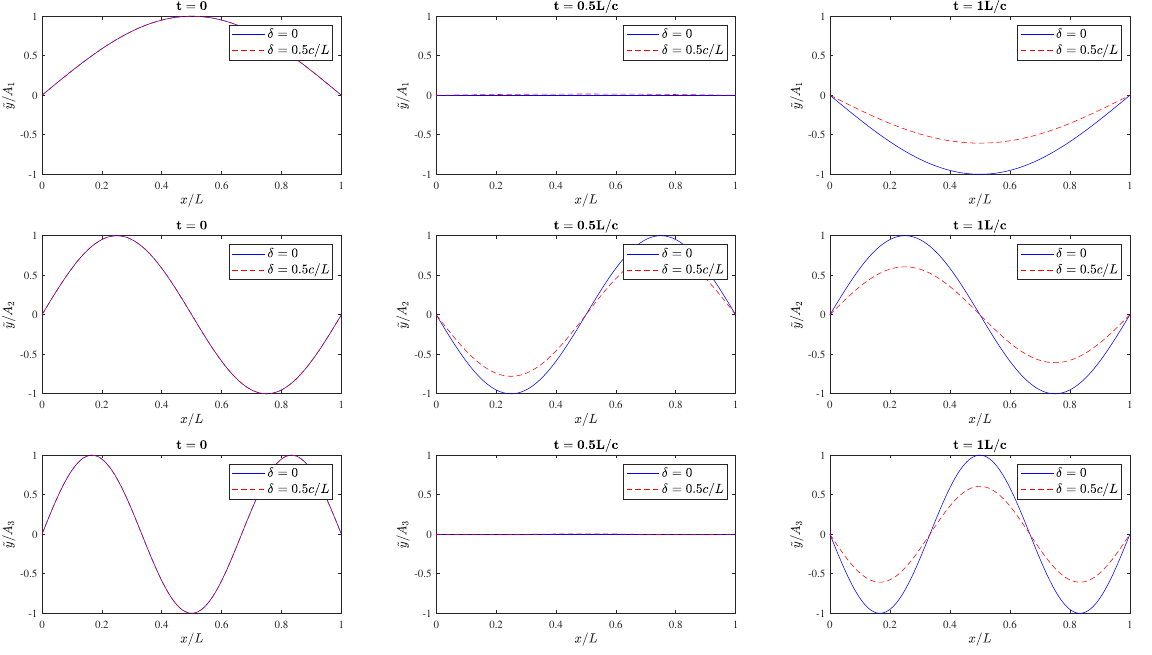
Figure 1. Free damped oscillations (for instance, of a string) at three distinct times. The blue solid lines are shown for no damping and the red dashed lines represent the oscillations with damping, δ = 0.5 c / L . Each row corresponds to a distinct set of values of the mode of free oscillation n and consequently on the value of wavenumber k n : the upper row is for { n , k n } = { 1, π / L } , the middle row is for { n , k n } = { 2,2 π / L } , and the bottom row is for { n , k n } = { 3,3 π / L } . The plots are obtained for α n =